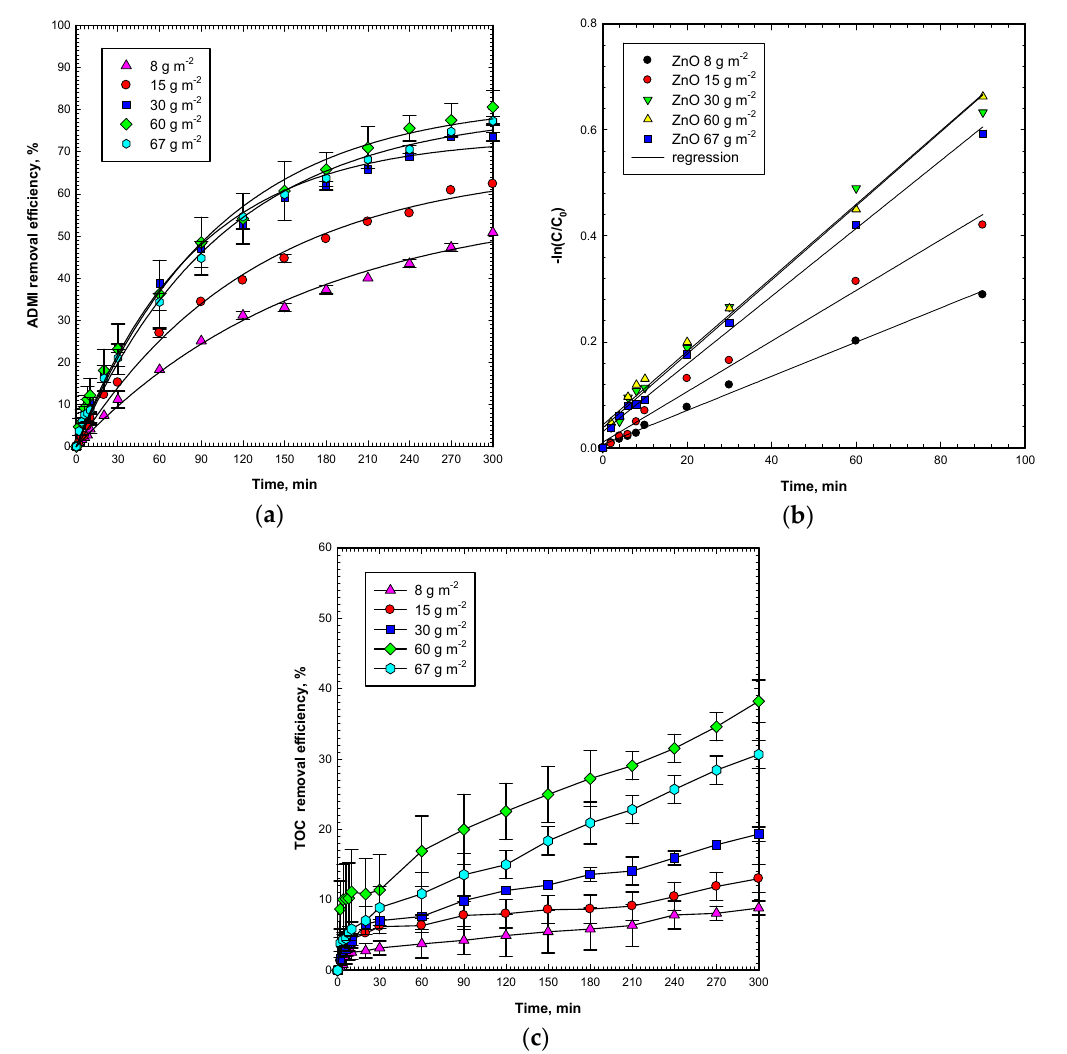
Figure 2. Effect of ZnO dosage on ( a ) OG degradation, ( b ) first-order kinetics, and ( c ) TOC removal by the Vis/ZnO process. The operating conditions were: initial OG concentration of 50 mg L − 1 , ZnO dosage of 8–67 g m − 2 , visible light intensity of 9600 Lux, and reaction time duration of 300 min.